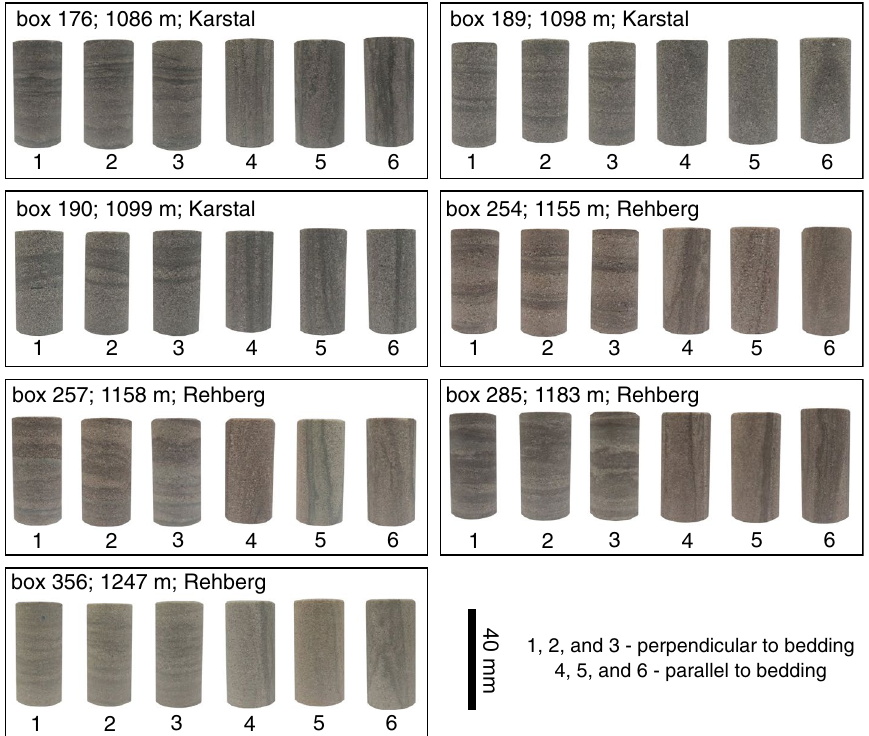
Fig. 4 Photographs of the 20-mm-diameter cylindrical core samples prepared from the seven cores shown in Fig. 3. Six samples were prepared from each core: three perpendicular to bedding (samples 1, 2, and 3) and three parallel to bedding (samples 4, 5, and 6). The box number, depth, and lithostratigraphic unit are provided next to each set of